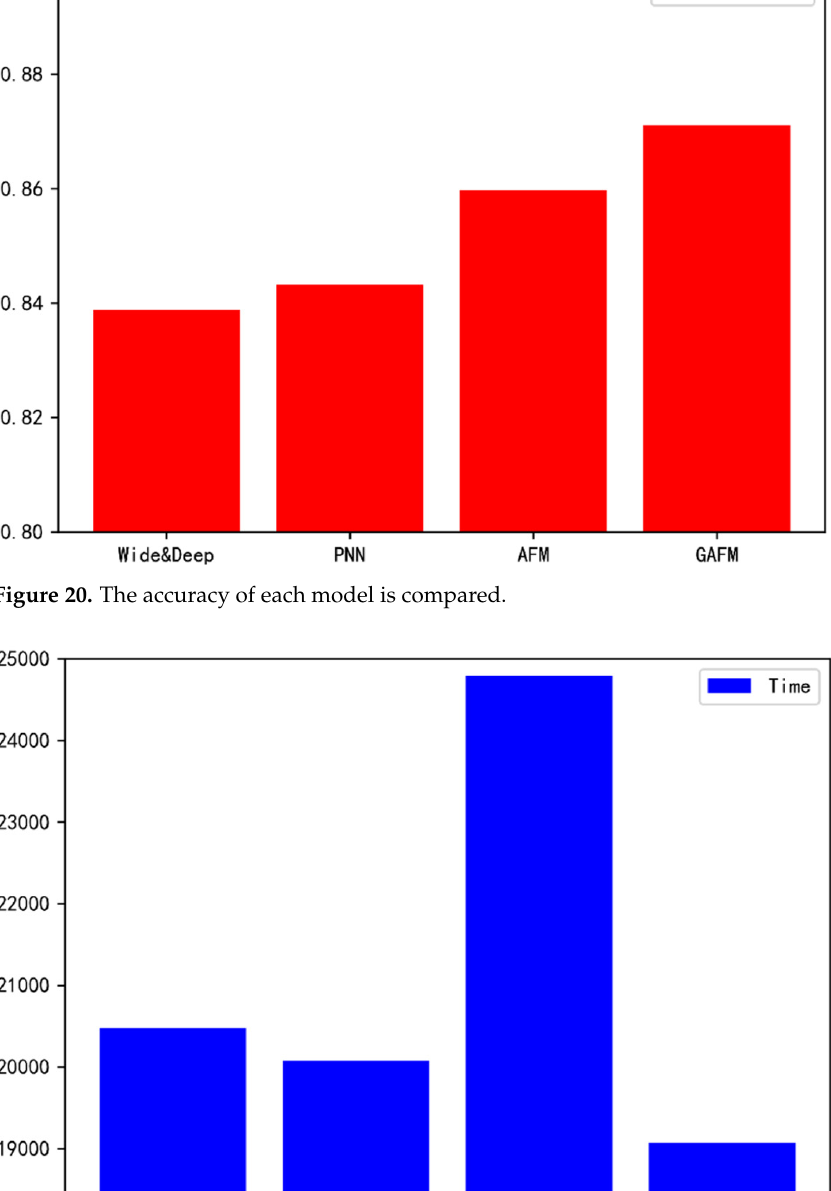
Figure 21. The running time of each model is compared.